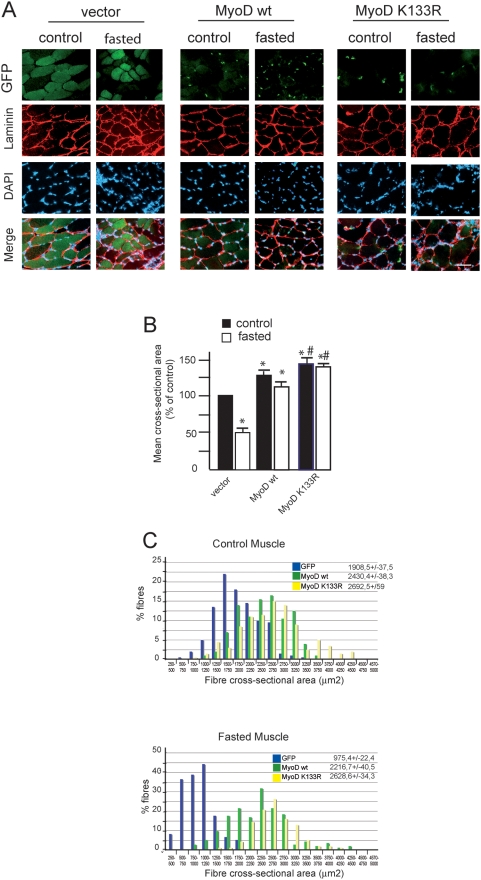
Expression of MyoD K133R in normal and fasted muscle fibres induces hypertrophy.A/ Representative cross-sectional areas of electroporated TA muscles from fed and starved mice. Adult Tibialis anterior (TA) muscles were electroporated with either a control (GFP), a MyoDwt-GFP or a MyoD mutant K133R-GFP plasmid. Mice (control or fasted by 2 days) were sacrificed 14 days later. Transfected fibres were identified on the basis of their GFP expression. The distribution of cross-sectional areas of EGFP-expressing fibres taken from four muscles under each conditions Fibres membranes were stained with polyclonal anti-laminin antibody. Scale bar, 20 µm. B/. Mean cross-sectional area of TA fibres in control (fed) and fasted mice (atrophy)±s.e.m. *P<0.05 between control and MyoDwt or MyoD K133R electrotransferred fibres. # P<0,05 between MyoDwt and MyoD K133R. n>200 fibres. C/. Histogram shows the fibre size distribution of TA from four mice per expression vector (in control: fed and atrophy: fasted mice). Blue bars, empty vector, green bars MyoDwt and yellow bars mutant MyoD K133R.